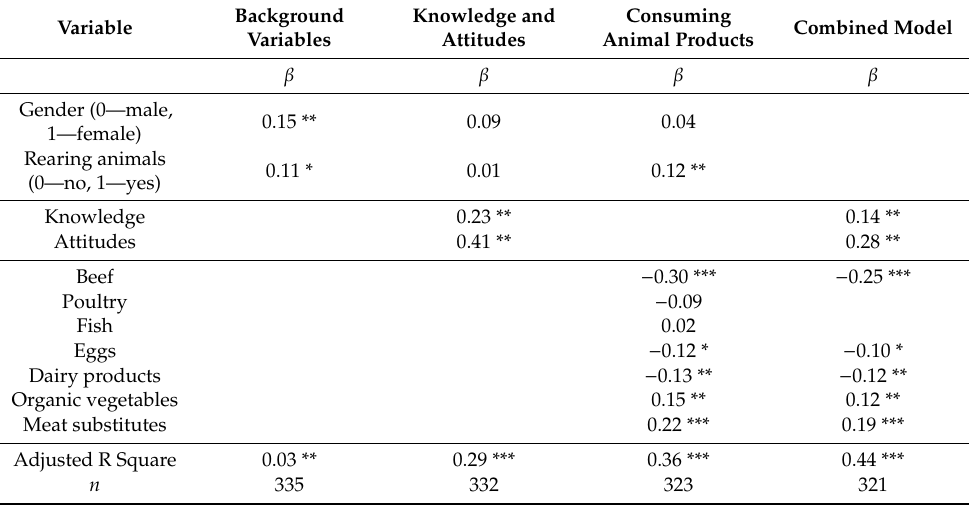
Table 5. Results of hierarchical linear regression models to predict pro-environmental behavior.